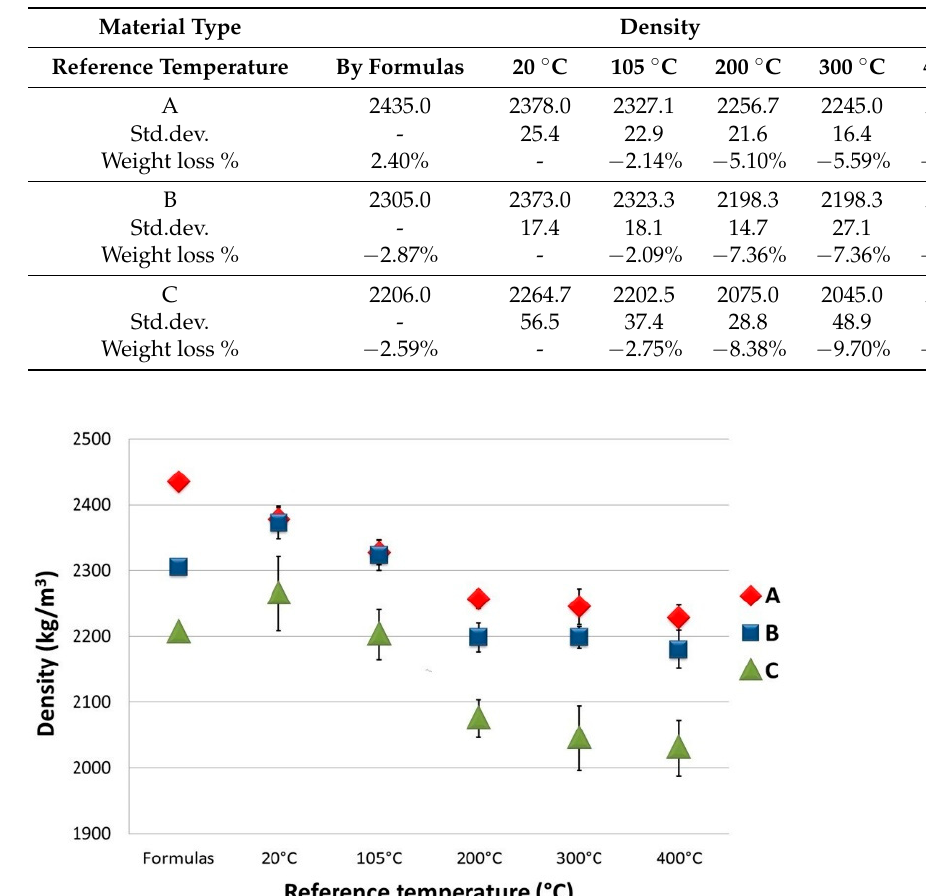
Table 5. Mix design density for fresh and hardened concrete as a function of heat treatment temperature.